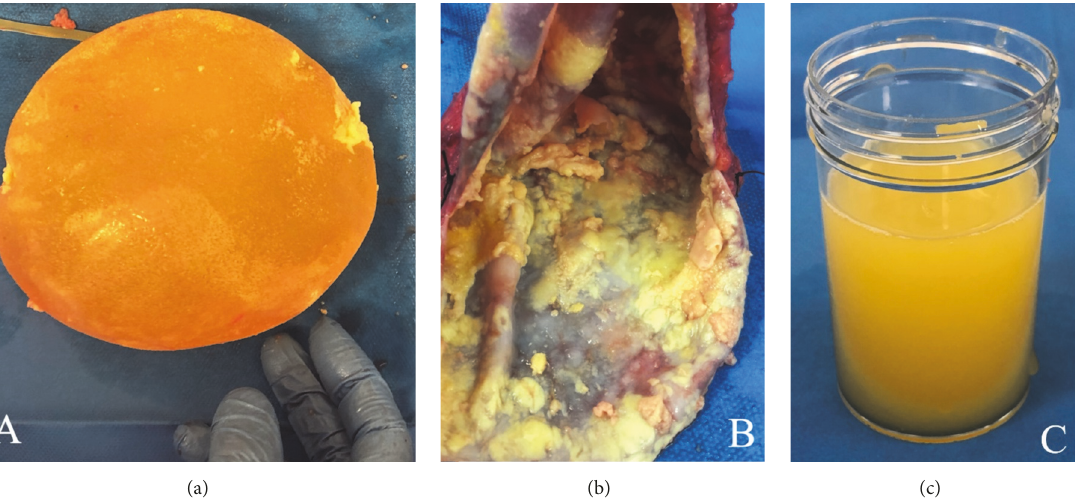
Figure2:(a)Surgicallyremovedtexturedsiliconeimplant.(b)Fibrouscapsulefromwhichtheimplantwasremoved;solidBIA-ALCLdeposits on the internal surface; (c) seroma fluid from inside the fibrous capsule which contained CD30-positive atypical